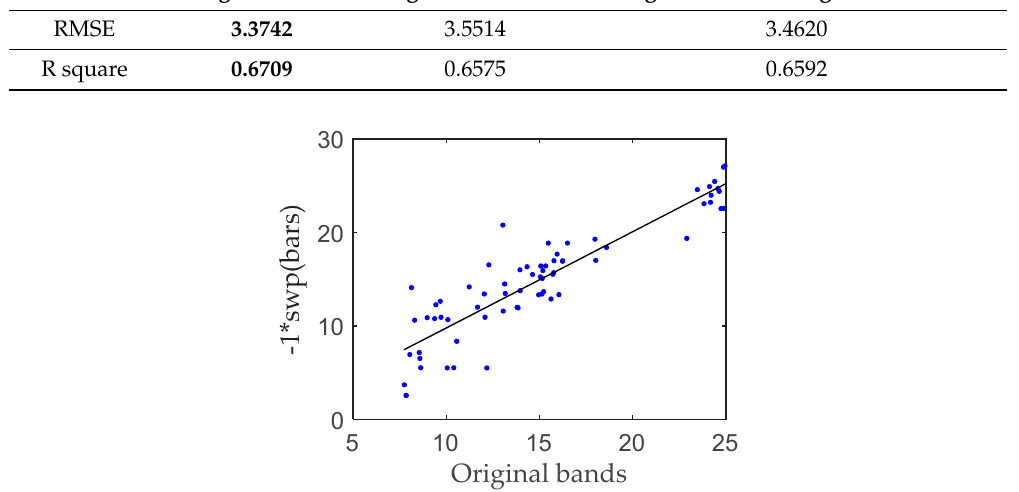
Figure 6. Scatterplots derived from random forest regression using original surface reflectance bands based on all 52 reference samples.